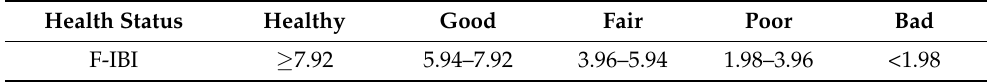
Table 4. Criteria of health assessment of the Hun River Basin using the